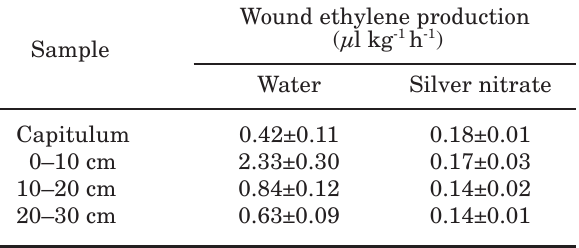
Table 1. Wound ethylene production (µl kg -1 h -1 ) from the flower (capitulum) and sections of gerbera scape (0–10 cm, 10–20 cm, and 20–30 cm from the base of the capit- ulum). Sections were excised after the immersion of the flower for 1 day in tap water or in silver nitrate solu- tion. Values are the means (µSD) of sections taken from 5